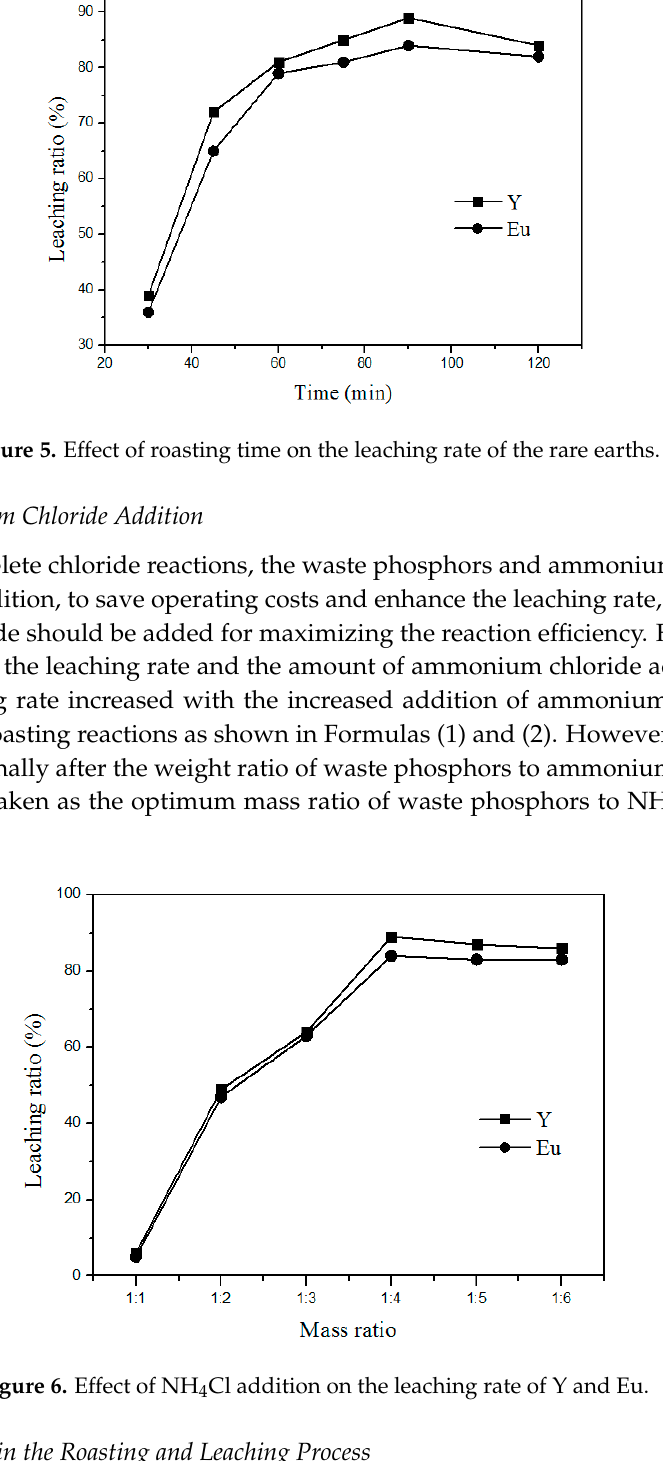
Figure 7. SEM-EDS analysis of the leach residue. Figure 8a shows the XRD pattern of waste phosphors after roasting at 400 °C. The pattern shows that the main phases transformed to YCl 3 , (CeTb)MgAl 11 O 19 , BaMgAl 10 O 17 :Eu 2+ , and SiO 2 , indicating that the red phosphors (Y 2 O 3 : Eu 3+ ) react with NH 4 Cl and form RECl 3 after roasting. The XRD pattern of the leaching residue (Figure 8b) shows that the main phases were SiO 2 , (CeTb)MgAl 11 O 19 , and BaMgAl 10 O 17 :Eu 2+ , indicating that RECl 3 was leached to the solution. This indicated that red